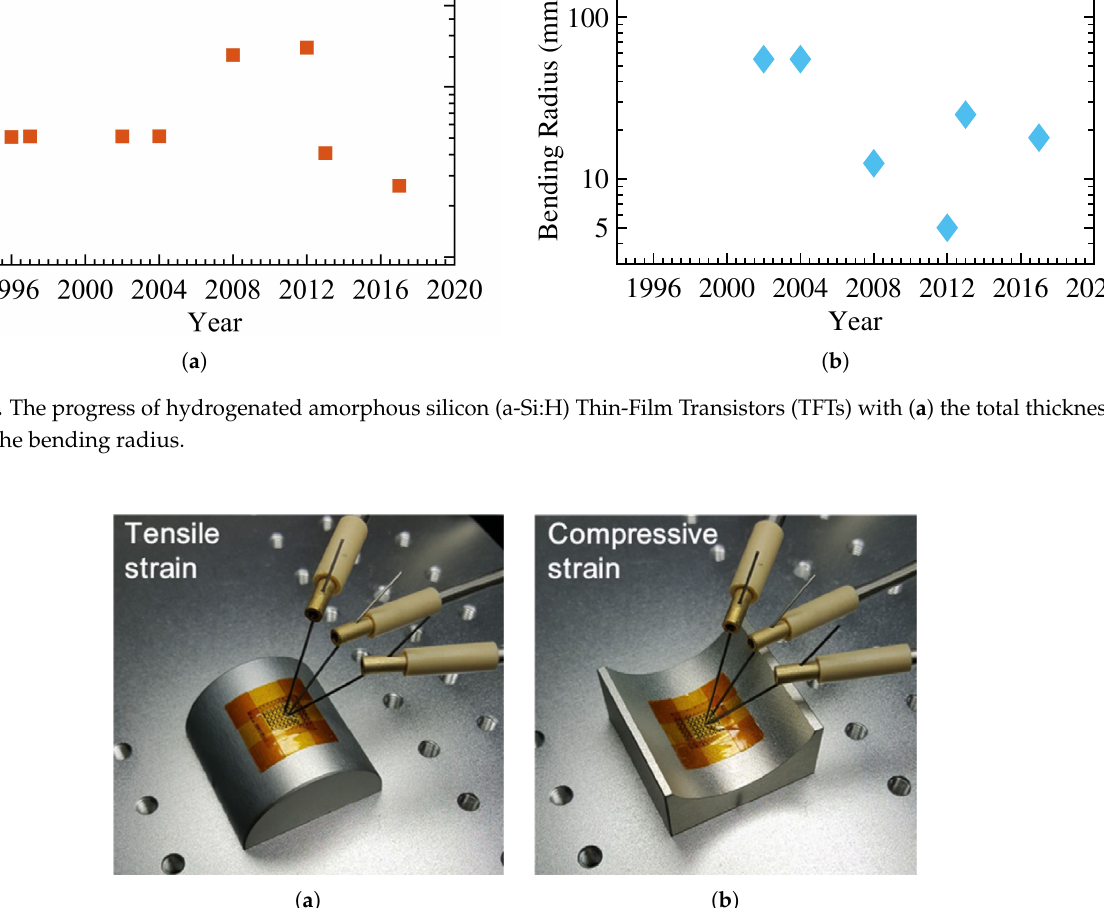
Figure 4. An example of physically flexible a-Si:H transistors under ( a ) tensile and ( b ) compressive strain [54]. Reproduced with